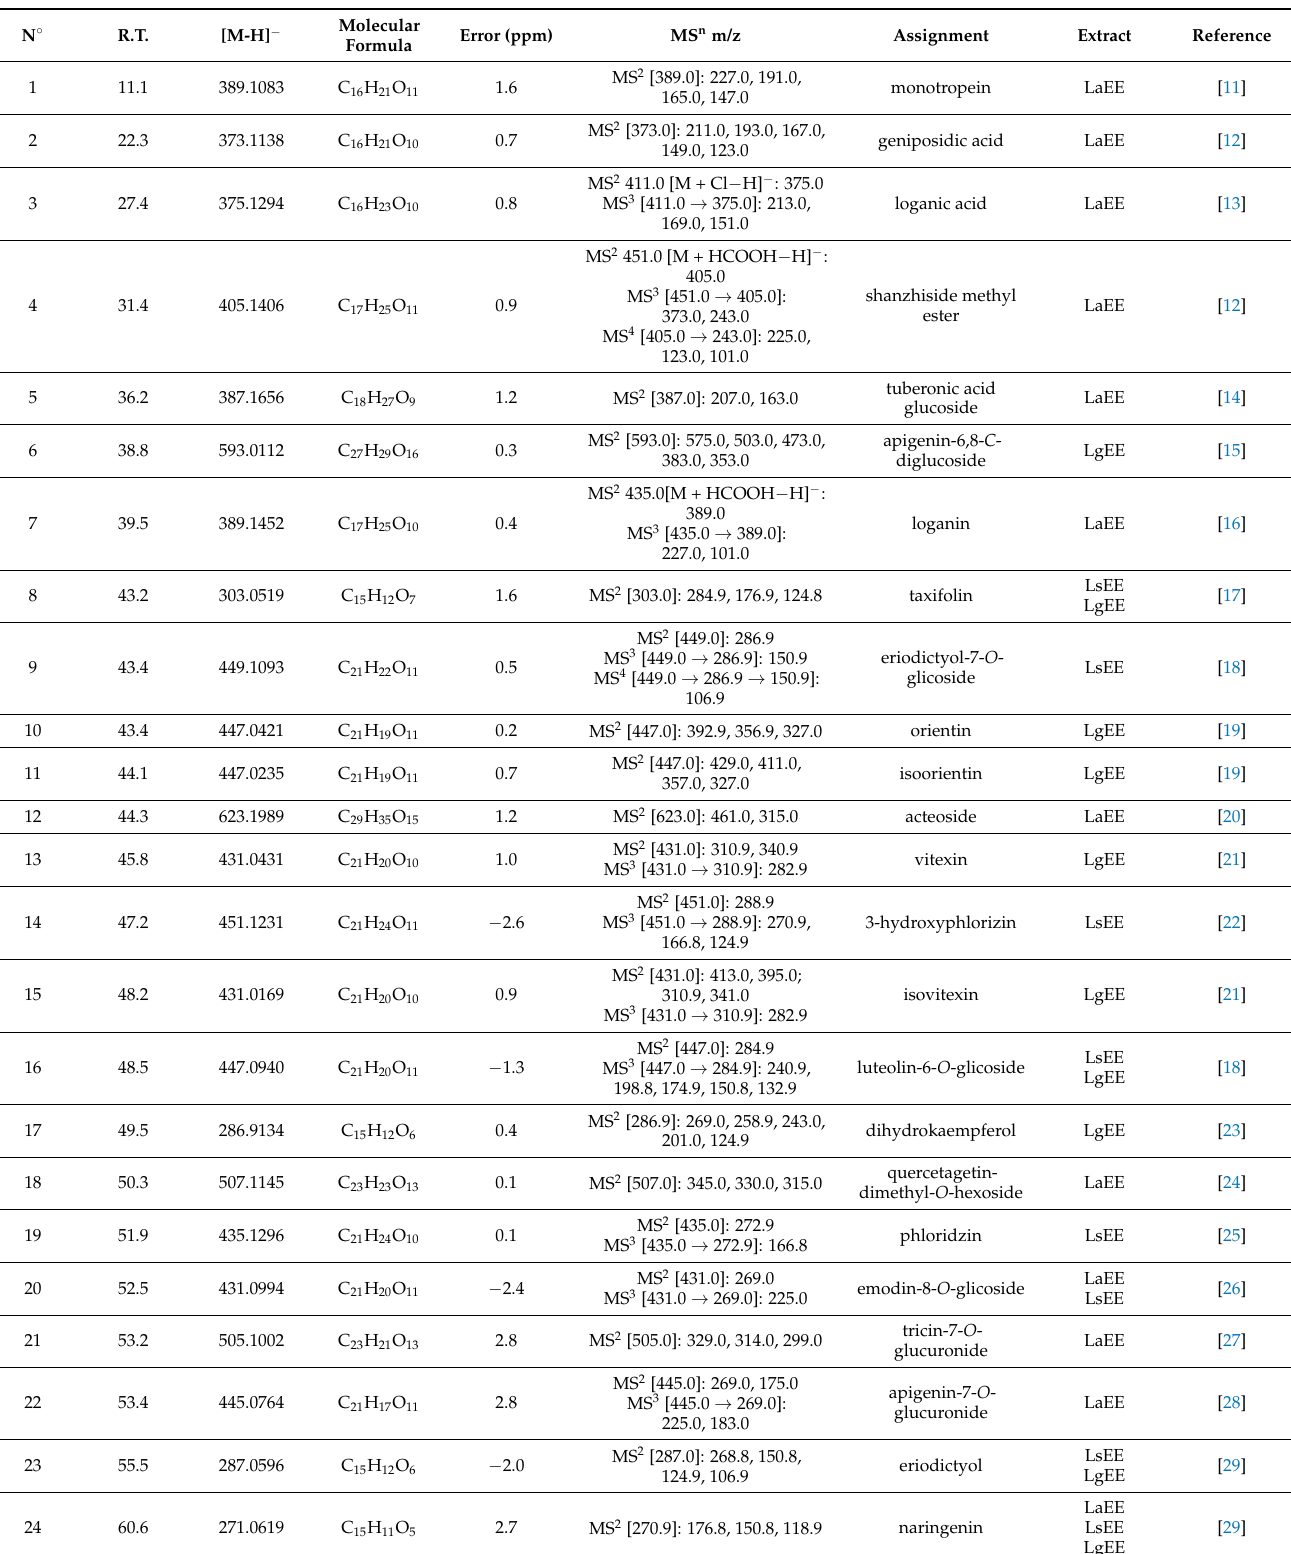
Table 1. Compounds identified by HPLC-DAD-ESI-MS n in ethanolic extracts of L. alba , L. sidoides, and L. gracilis